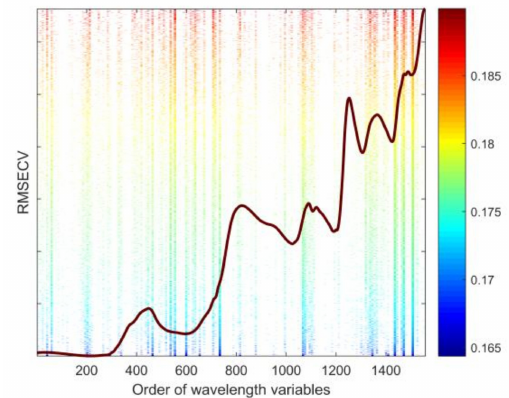
Figure 5. The feature wavelengths identified by 3315 optimal models and their root mean square error calculated from cross-validation (RMSECV) results after performing iterative operations with the genetic